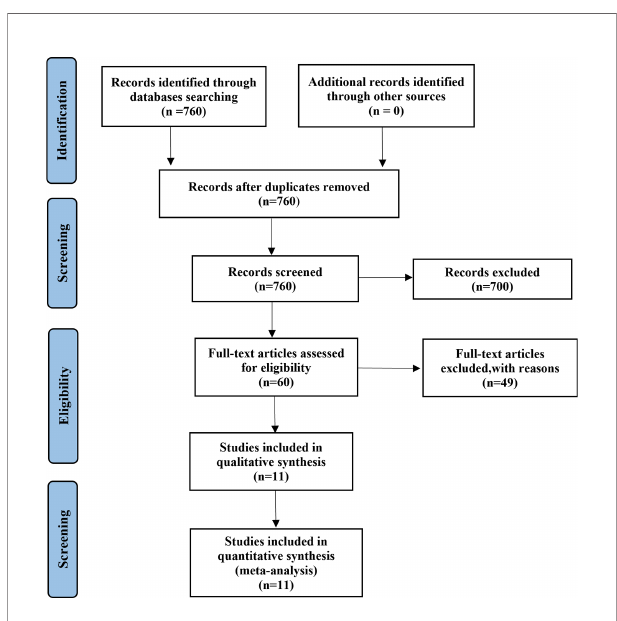
FIGURE 1 | Study selection fl ow diagram.